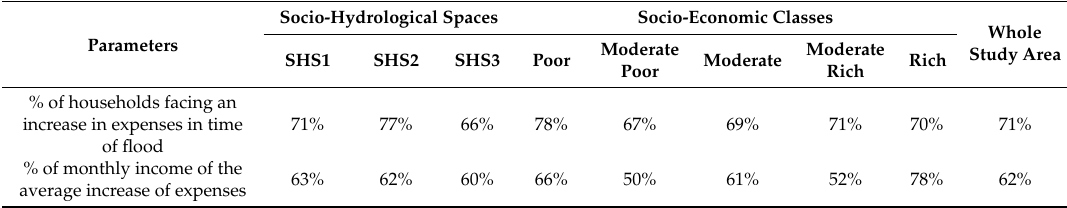
Table 4. Increase in expenses due to flood in the study area.